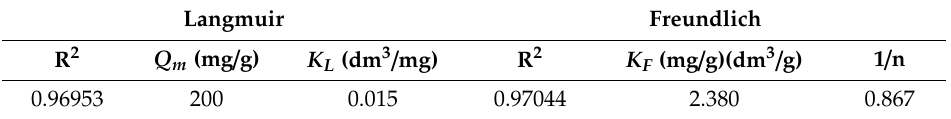
Table 5. Comparison of K F with previous studies.